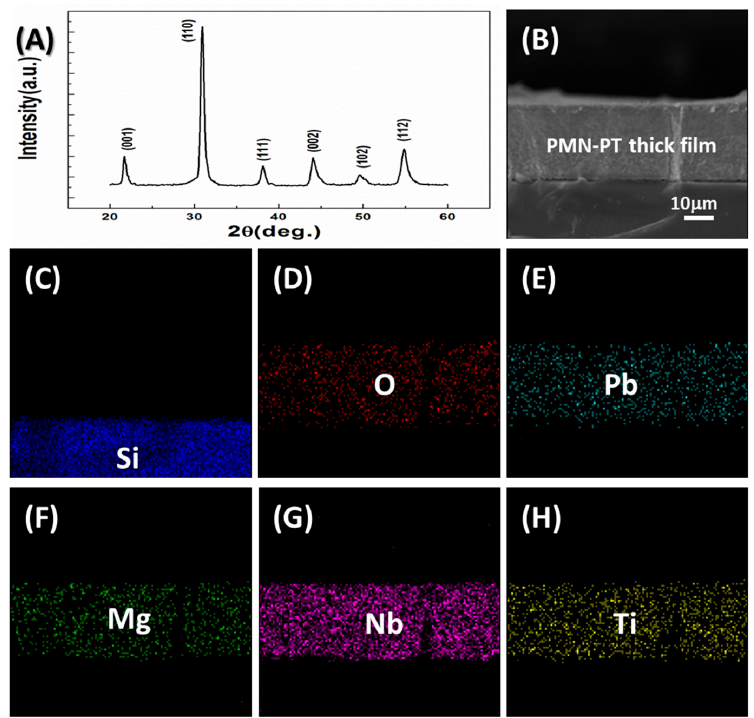
Figure 1. ( A ) XRD pattern and ( B ) SEM cross-sectional image of Pb(Mg 1/3 Nb 2/3 )O 3 –PbTiO 3 (PMN-PT) thick film on silicon wafer; ( C – H ) cross-sectional elements distribution in the PMN-PT thick film on silicon substrate.